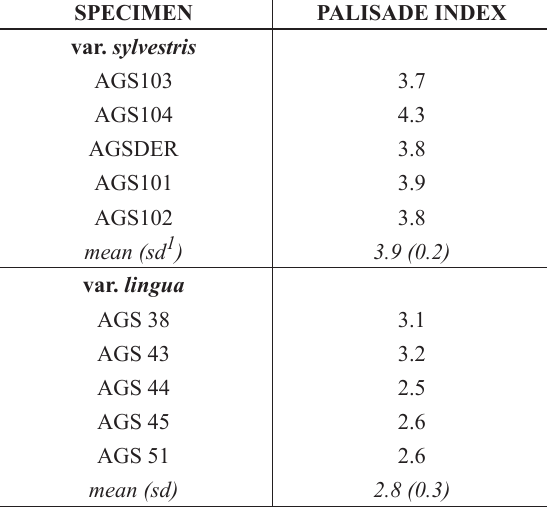
Palisade index for specimens of C. sylvestris .